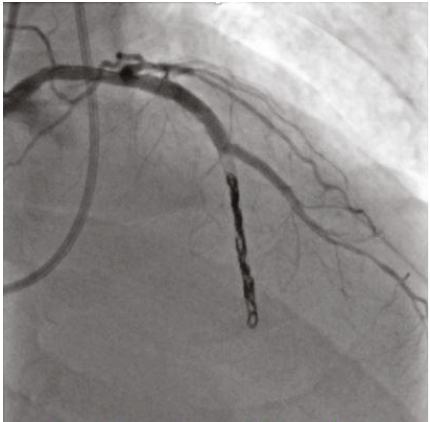
Figure 4: Angiography of the LAD showing successful coil embolization and complete cessation of fl ow into the RV.